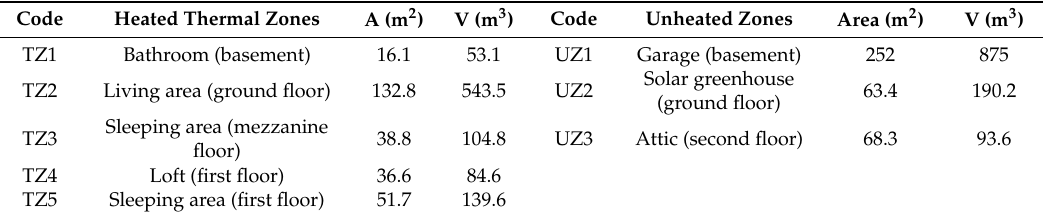
Table 2. Subdivision of the building into heated thermal zones and unheated zones. (A = net surface; V = net volume).